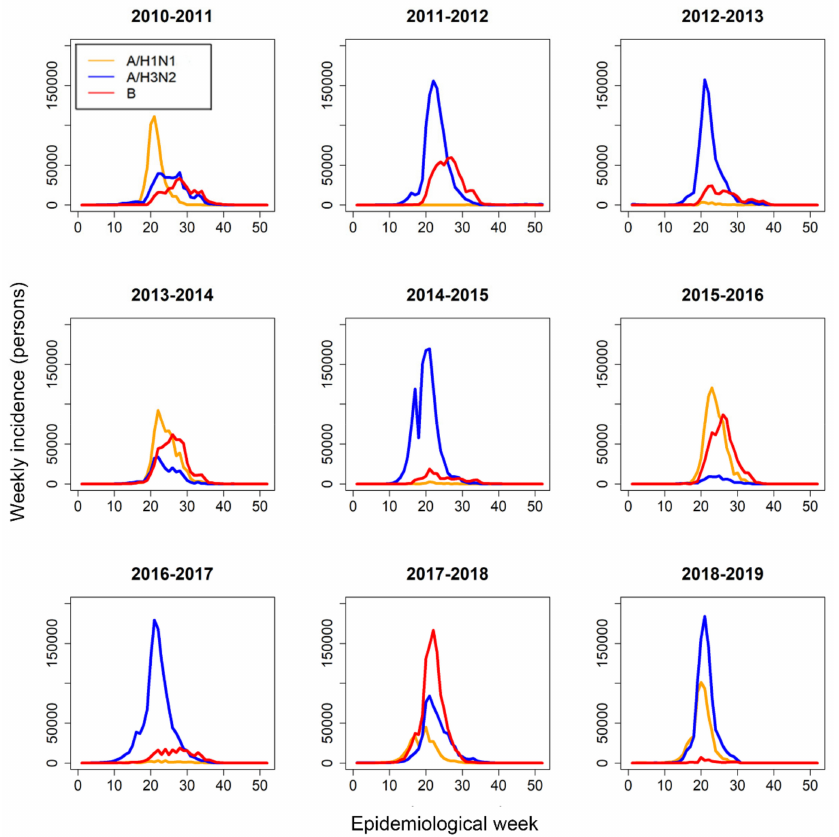
Figure 1. Temporal distribution of the weekly incidence of three influenza virus types, A / H1N1 (orange), A / H3N2 (blue), and B (red) from 2010 to 2019. Epidemiological week 1 corresponds to calendar week 36 in each